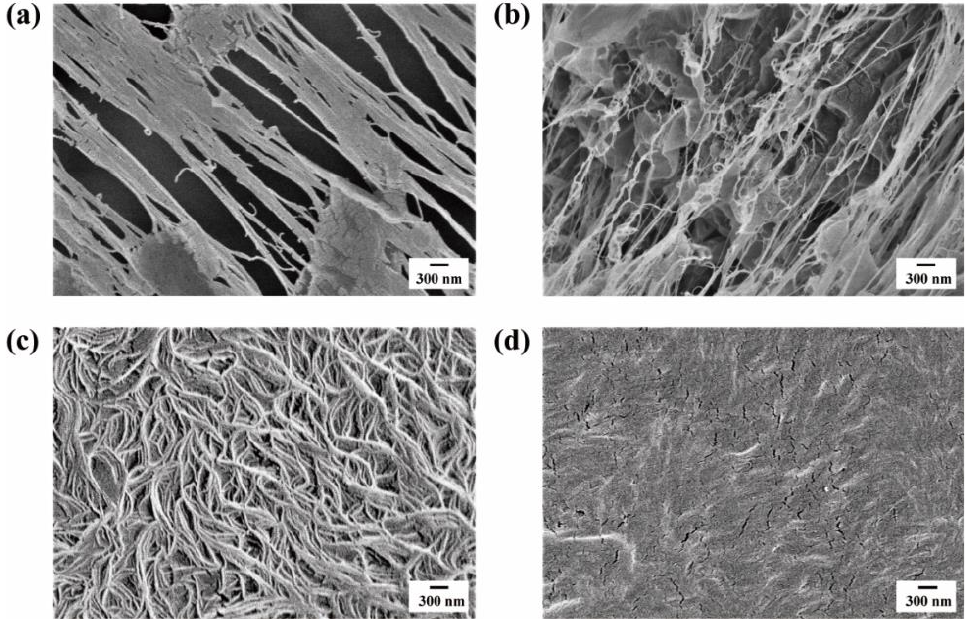
Figure 1. SEM images of ( a ) PE1.1M — 0.1 wt%, ( b ) PE0.5M — 0.1 wt%, ( c ) PE1.1M — 5 wt% and ( d ) PE0.5M — 10 wt%.